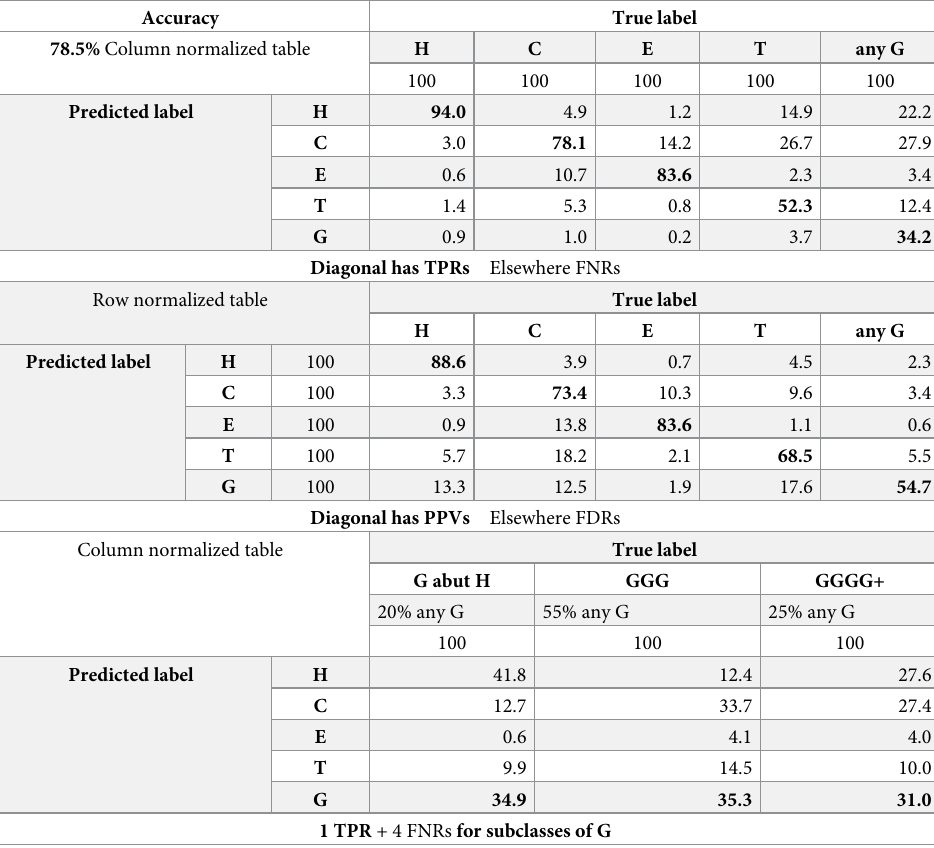
1 TPR + 4 FNRs for subclasses of G The 5 practical labels are defined as: ( S , B ) ! ( C ) and ( I ) ! ( H ). Bottom : Same 5-label alphabet. The G recalls and FNRs are shown for 3 subclasses of G where any true G ‘s ( G column in the Middle section) are assigned into: (a) The dominant FNR of 33.7% for C in the prevailing GGG subclass of 55% and almost equal FNRs for H and C of 27.6% and 27.4% in the 25% GGGG+ subclass outweigh the dominant FNR for H of 41.8% in the minority G -abut- H subclass of only